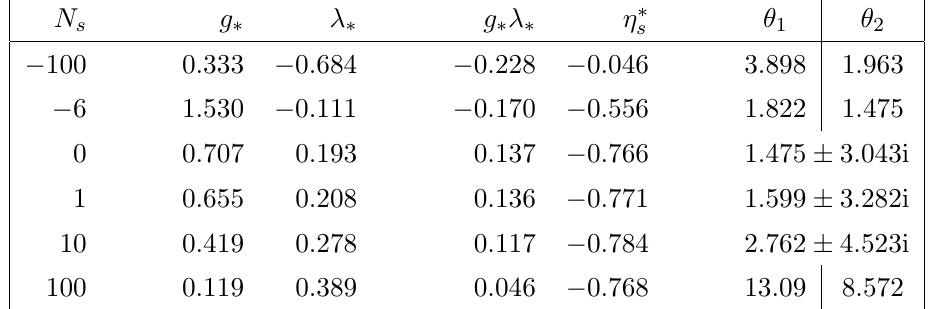
Table 1 . Characteristic quantities for the NGFP appearing at selected values of N s . The case N s = 0 corresponds to the Einstein-Hilbert